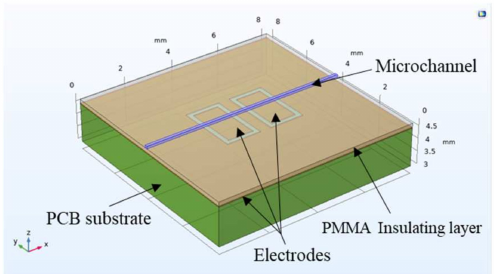
Figure A1. Three-dimensional model of the prototyped